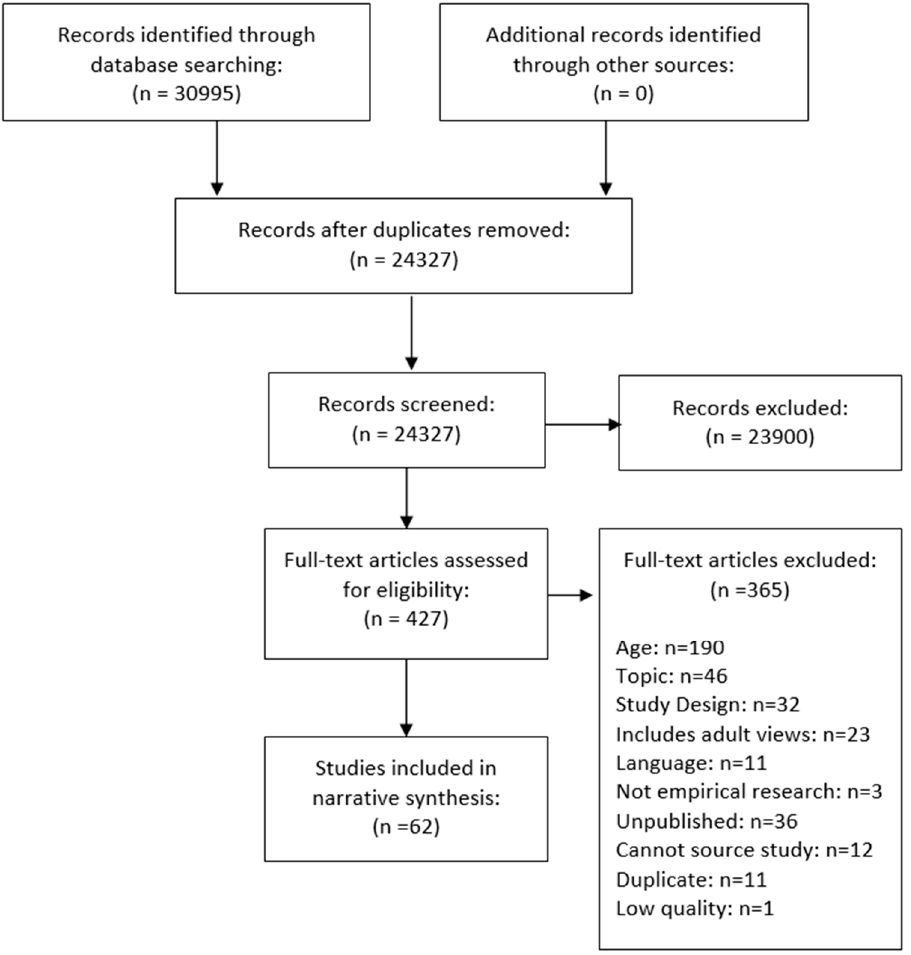
Figure 1. Flow chart showing study selection process .